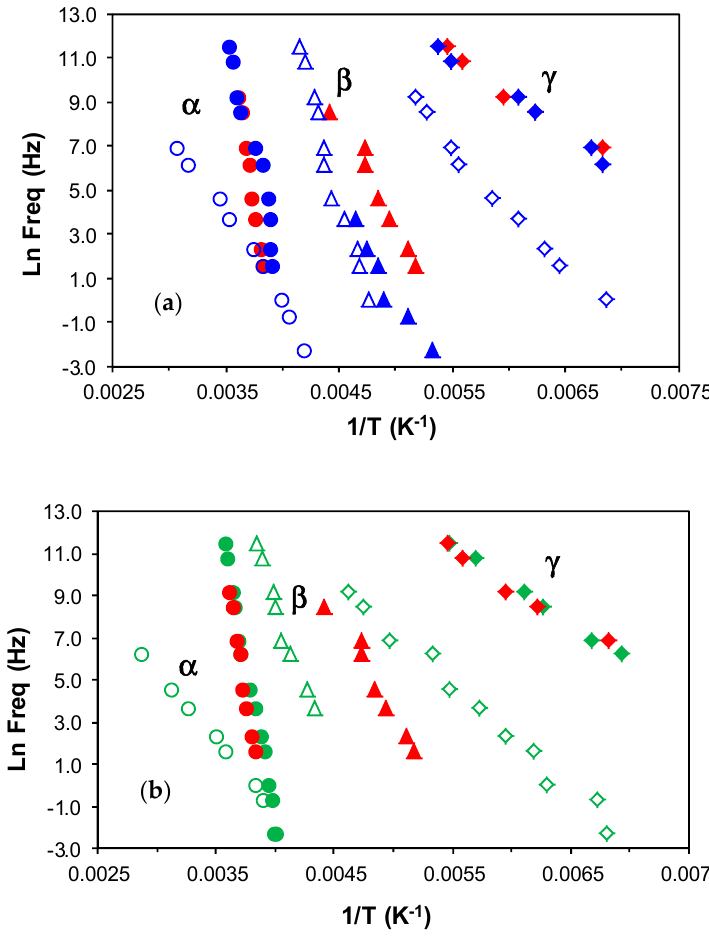
Figure 11. Relaxation map comparing epoxy (red) with HBPEIs (open symbols) and uncured ELP mixtures (filled symbols) of different MWs: ( a ) PEI800, ELP800, blue symbols; ( b ) PEI25000, ELP25000, green symbols. α -relaxation (circles); β -relaxation (triangles); γ -relaxation (rhombus). Heating rate 2 °C/min.